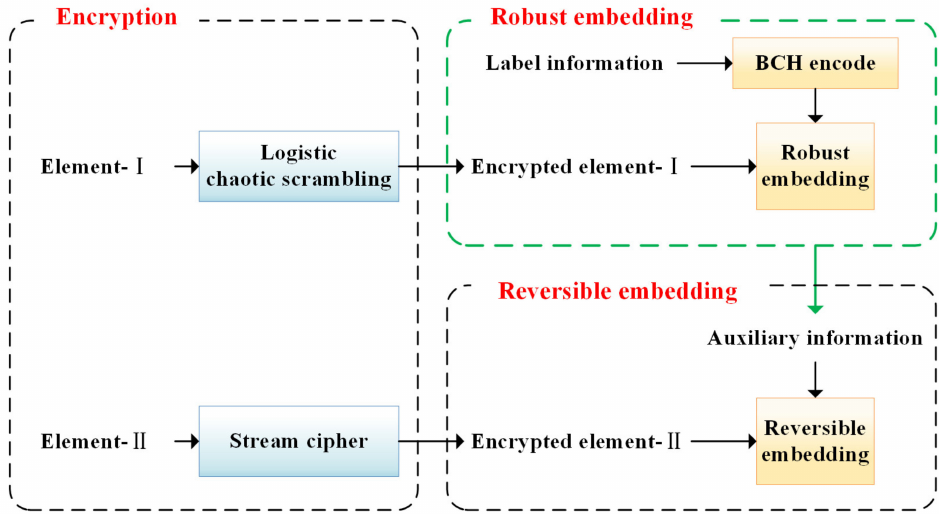
Figure 1. Framework of multi-domain embedding in encrypted